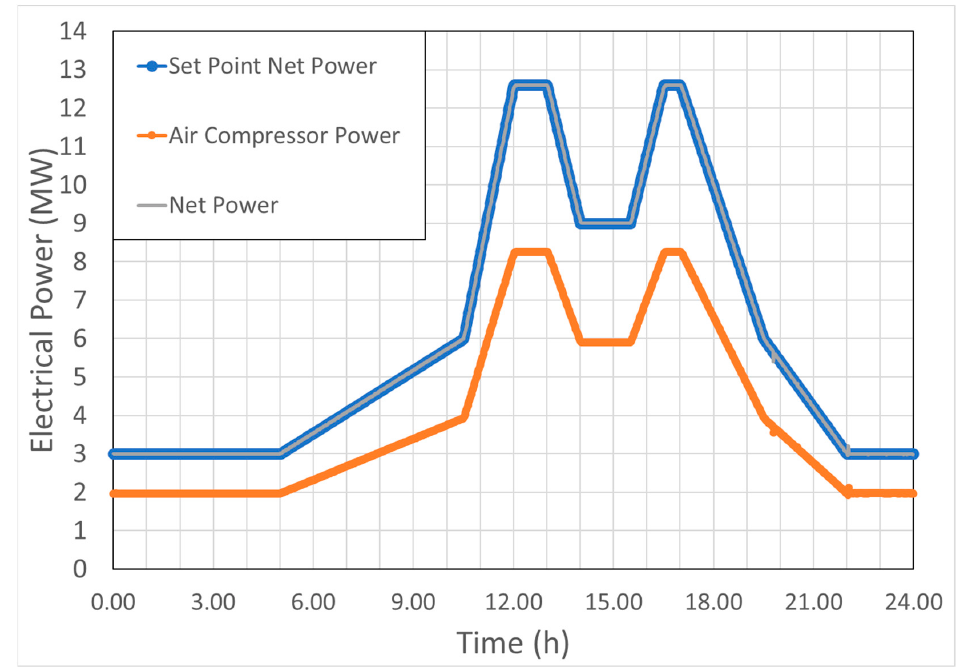
Figure 5. Trends of daily electrical energy production.